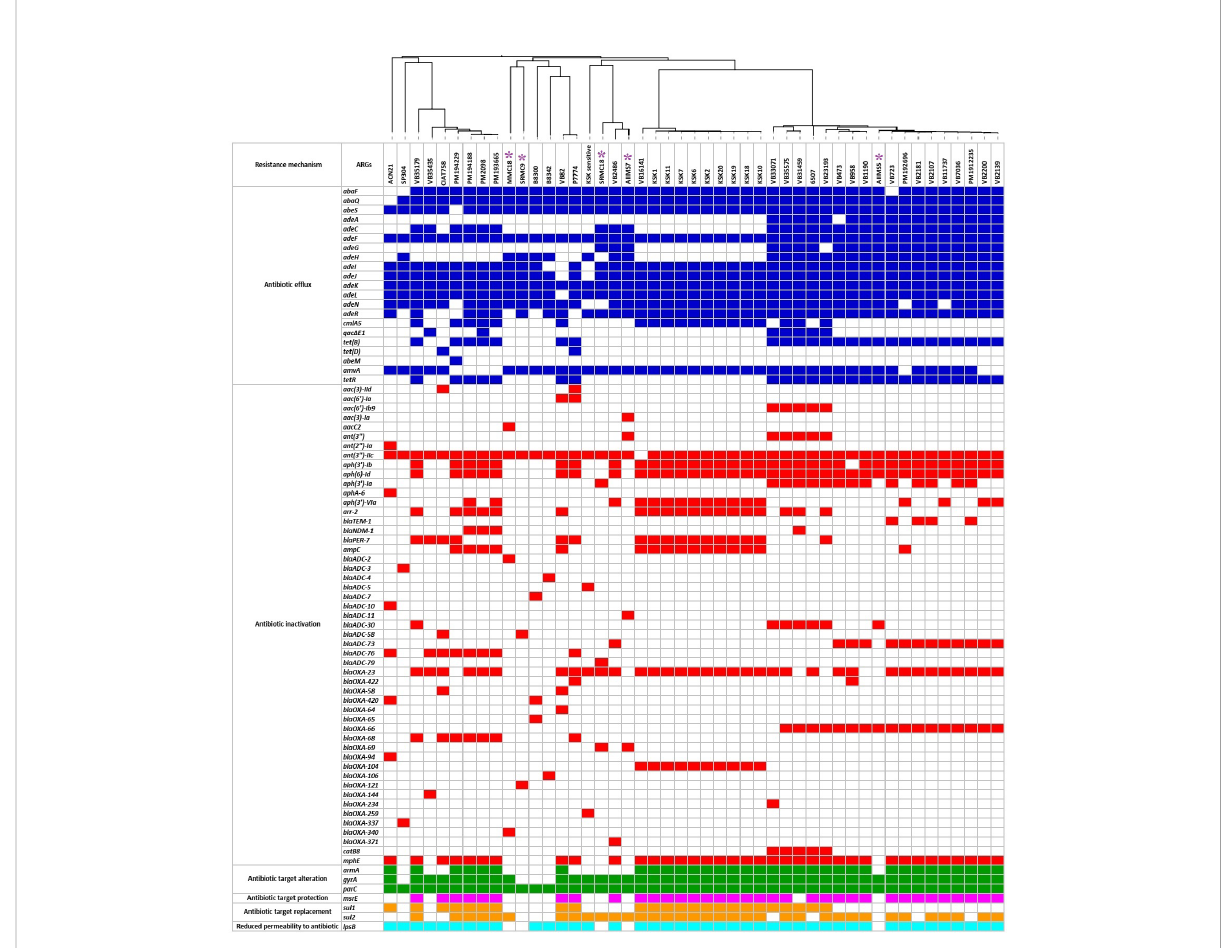
FIGURE 2 The predicted resistome of 47 A . baumannii genomes from India. The colored squares represent presence of ARGs while the empty or colorless squares represent absence of ARGs. The purple asterisks represent fi ve A. baumannii isolates sequenced in this